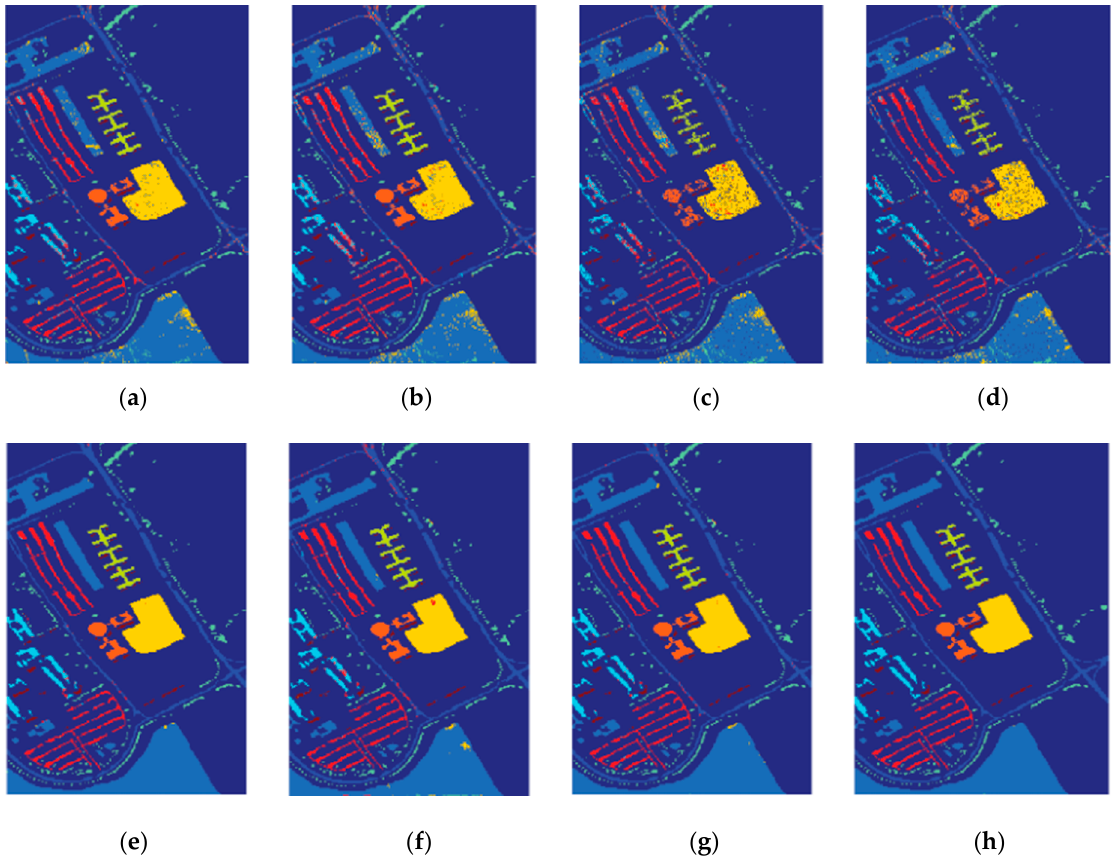
Figure 6. Classification map of the University of Pavia: ( a ) ELM, ( b ) KELM, ( c ) WKELM, ( d ) SS-KELM, ( e ) KELM-CK, ( f ) ASS-H-DELM, ( g ) HCKBoost, and ( h ) DW-KELM. Table 3. OA, AA, and kappa (%) obtained by different approaches on the Pavia University data set for different classes. Class